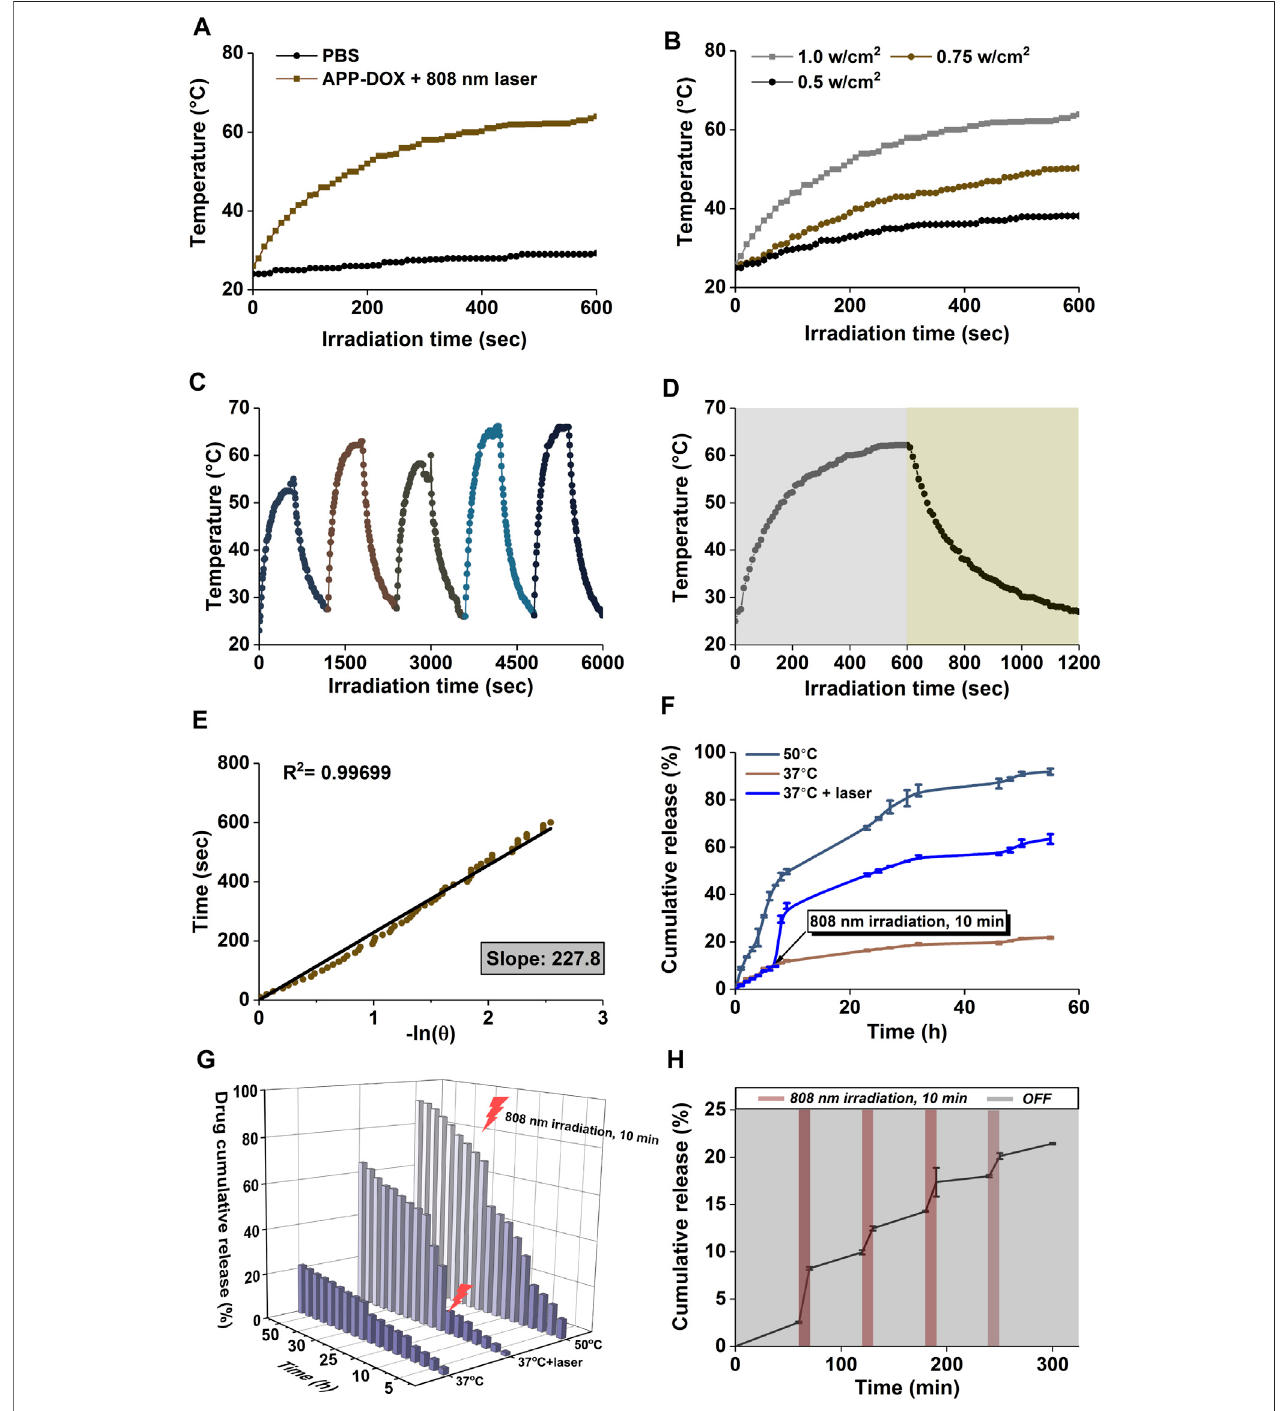
FIGURE 2 | Temperature change curves of APP-DOX solution and the same amount of PBS under laser irradiation (808 nm, 10 min) (A) . Temperature change curves of APP-DOX solution under laser irradiation of different power densities (B) . Temperature change curves of APP-DOX solution during the on/off switching cycles of laser irradiation (C) . Temperature change curvesof APP-DOX solution in a single on/off process of laser irradiation (D) . Relationship between the cooling time and the negative natural logarithm of temperature driving force after the laser was turned off (E) . Cumulative drug release curves (F) and the corresponding three- dimensional numerical histogram (G) of APP-DOX in pH 5.0 buffer at 37 ° C, at 50 ° C, and under the stimulation of NIR laser irradiation. Drug release curve of APP-DOX over 300 min of on/off cycles of NIR laser irradiation (H) .